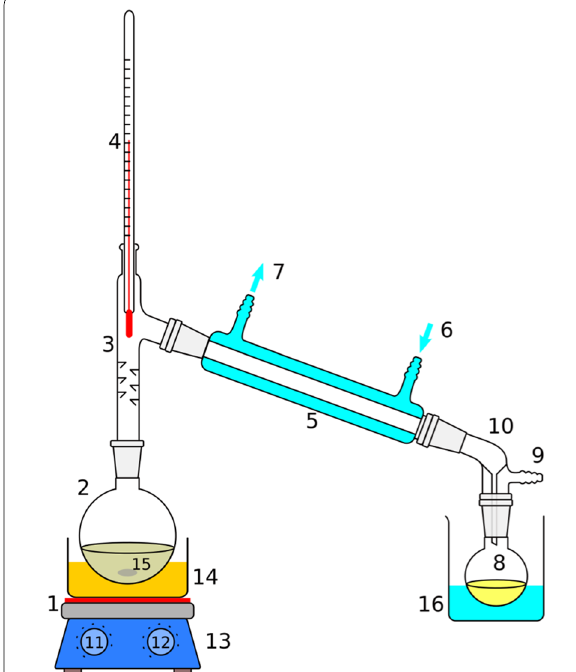
Fig. 2 Fractional distillation unit. 1—Hot plate disc, 2—round flask (1 L), 3—reflux condenser, 4—thermometer, 5—condenser, 6— cooling water in, 7—cooling water out, 8—distillate fraction, 9— blind connection, 10—quick fit glass connection, 11—heating key,